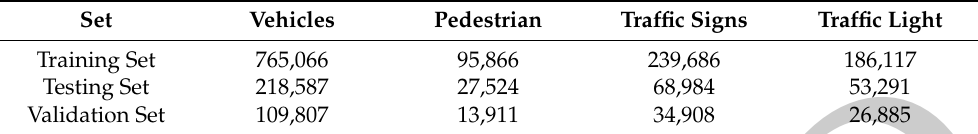
Table 4. The number of annotated objects in the Berkeley Deep Drive (BDD100K) dataset.